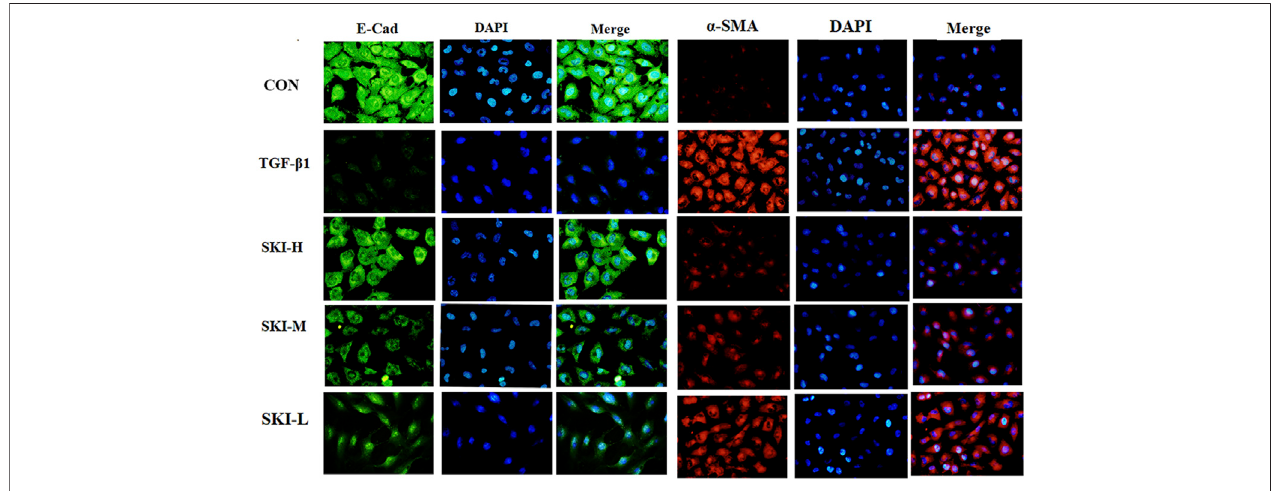
FIGURE 9 | Shenkang injection can inhibit EMT of HK-2 cells. Fluorescence intensity was analyzed with E-Cad (green) and α -SMA (red) antibodies by immuno fl uorescence method, and nuclei were stained with DAPI (blue). Then the three fl uorescence images were merged.